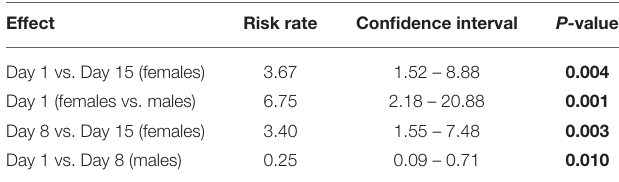
TABLE 4 | Significant risk rate of pigs having a tail lesion score recorded (based on the severity score sheet, adapted from Kritas and Morrison (27)) by sample day of study #2.